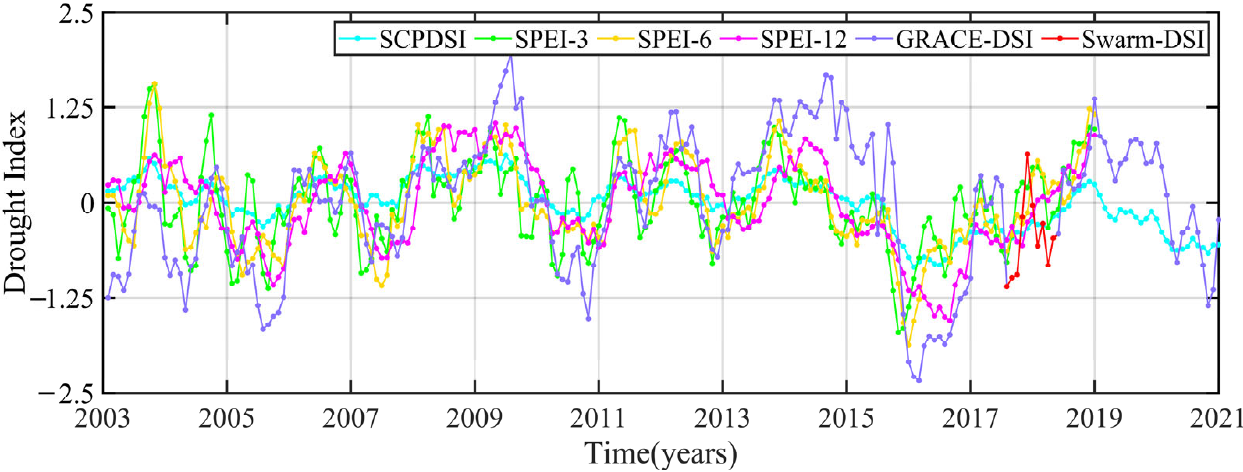
Figure 8. The time-series of GRACE/Swarm-DSI, SCPDSI, SPEI-3, SPEI-6 and SPEI-12 in the ARB during 2003–2020.